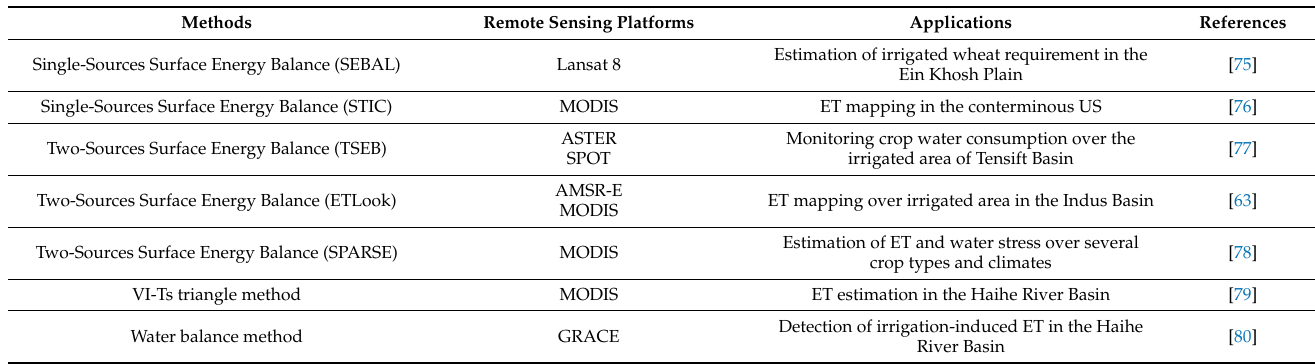
Table 1. Brief overview of different remote sensing-based methods and products to estimate ET over irrigated